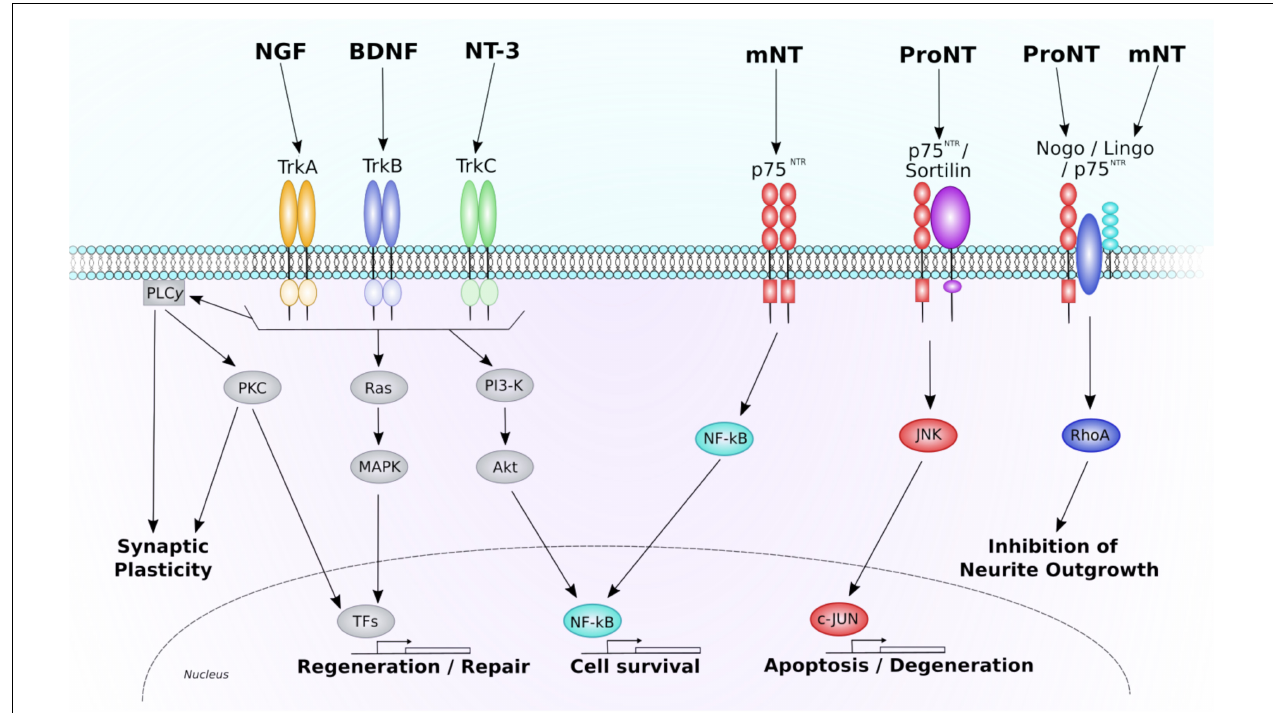
FIGURE 1 | Neurotrophin signaling through the p75 NTR and Trk receptors. This diagram depicts the major intracellular signaling pathways associated through each neurotrophin receptor. Each Trk receptor isoform binds mature neurotrophins and acts through three predominant pathways. Activation of PLC- γ 1 results in PKC-mediated promotion of synaptic plasticity. Activation of Ras initiates MAPK-mediated promotion of neuronal regeneration and growth. Activation of PI3-K results in activation of Akt and promotion of NF- κ B-mediated cell survival. Each of these pathways are also known to regulate genetic transcription, further promoting pro-survival, and regenerative gene expression. The p75 NTR receptor also regulates three main pathways. When a mature neurotrophin binds to an isolated p75 NTR NF- κ B-mediated cell survival is promoted. If the p75 NTR is co-expressed with the sortilin receptor, pro-neurotrophins can bind, and cause activation of JNK-c-Jun mediated cell death and degeneration. A receptor complex consisting of Nogo, p75 NTR , and Lingo1 can bind both pro- and mature-neurotrophins to alter neurite outgrowth in a RhoA-dependent manner. NGF, nerve growth factor; BDNF, brain-derived neurotrophic factor; NT-3, neurotrophin-3; Trk, tropomyosin receptor kinase; mNT, mature neurotrophin; ProNT, proneurotrophin; p75 NTR , pan neurotrophin receptor 75; PLC y1 , phospholipase C gamma one; PKC, protein kinase C; MAPK, mitogen-activated protein kinase; TFs, transcription factors; PI3-K, phosphoinositide 3-kinase; NF-kB, nuclear factor kappa-light-chain-enhancer of activated B cells; JNK, c-Jun N-terminal